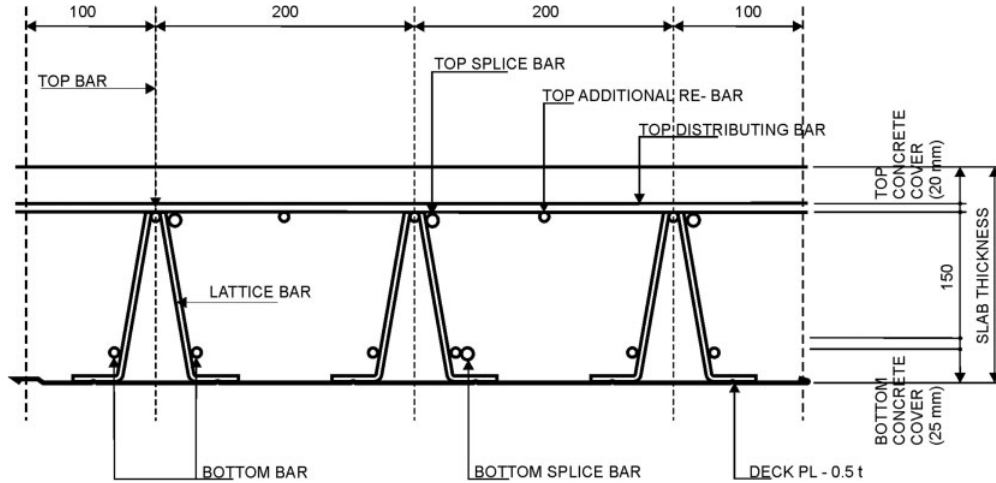
Fig. 4. Cross-section of the typical composite deck